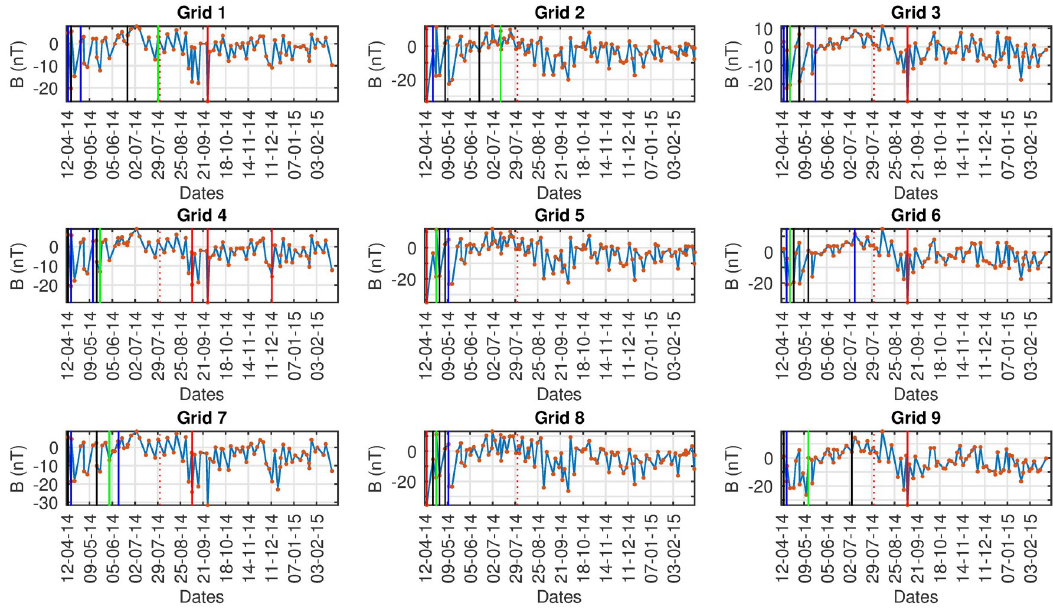
Fig 10. AD results Swarm C, red: CE , black: Fuzzy, blue: D-SAX , green: SAX.